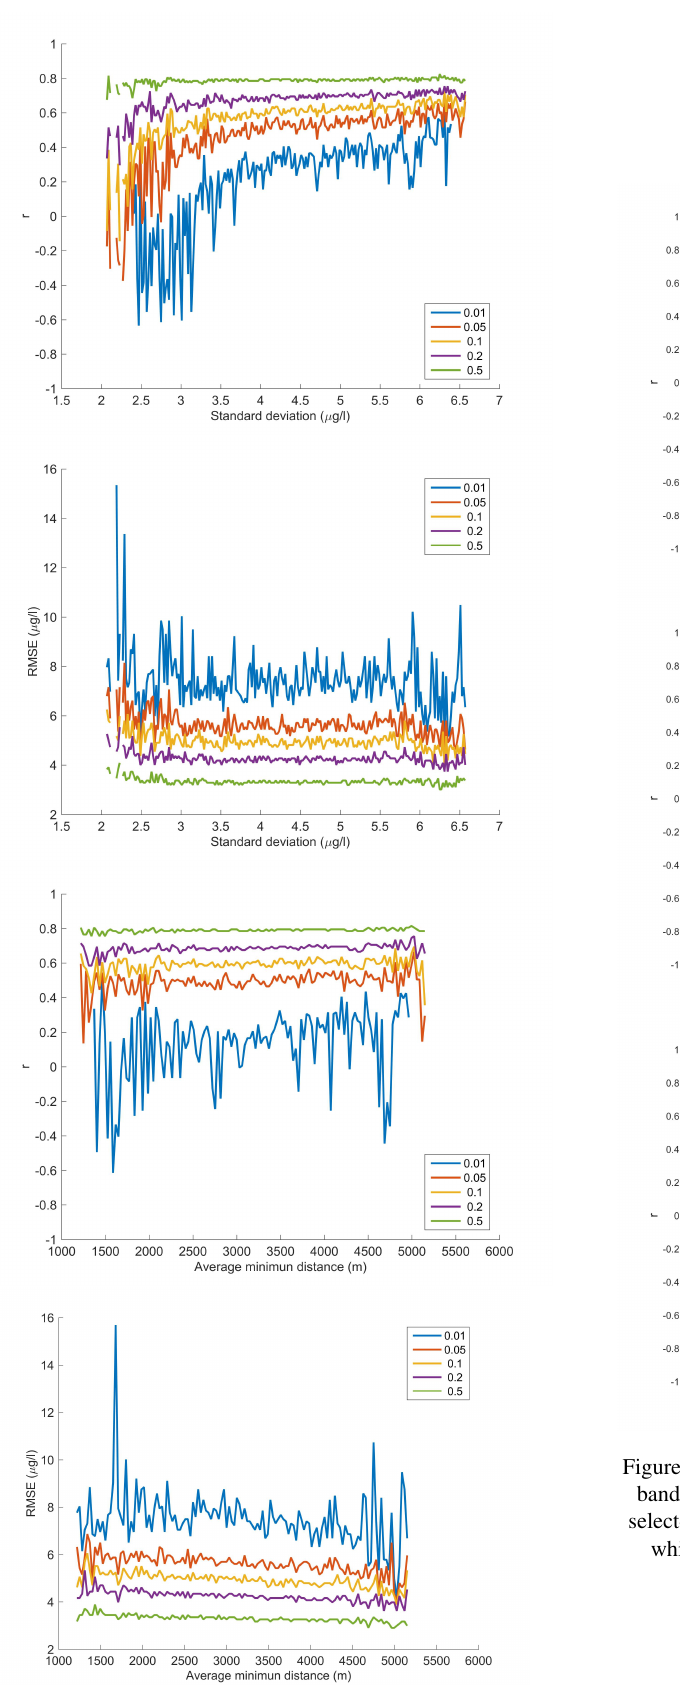
Figure 6. Correlation coefficient r (top and second from bottom) and root mean square error (RMSE) (second from top and bottom) for different probability levels. All figues: 12 randomly selected reference samples, 50000 random selection and 5 bands.